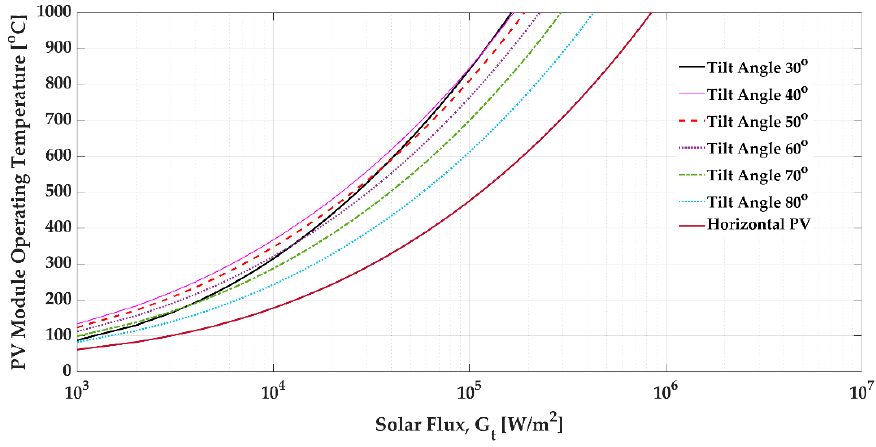
Figure 9. PV module operating temperature vs. solar flux with γ = 90° , horizontal PV module and an inclined PV module at η = 12% , without a cooling system.